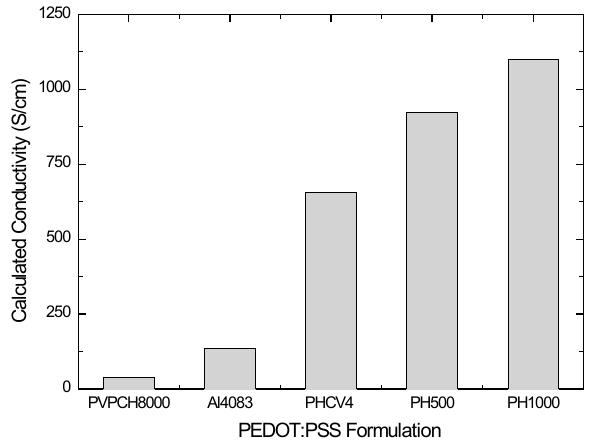
Figure 6. Calculated conductivity values by the modelling of the measured < (cid:101) ε ( ω ) > by Spectroscopic Ellipsometry (SE) of the different PEDOT:PSS formulations.